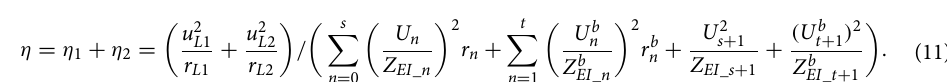
Figure 4. ( a ) The mutual inductance model of two helical triangular coils. ( b ) Simulation results of coupling between two adjacent coils. ( c ) Simulation results of coupling of three